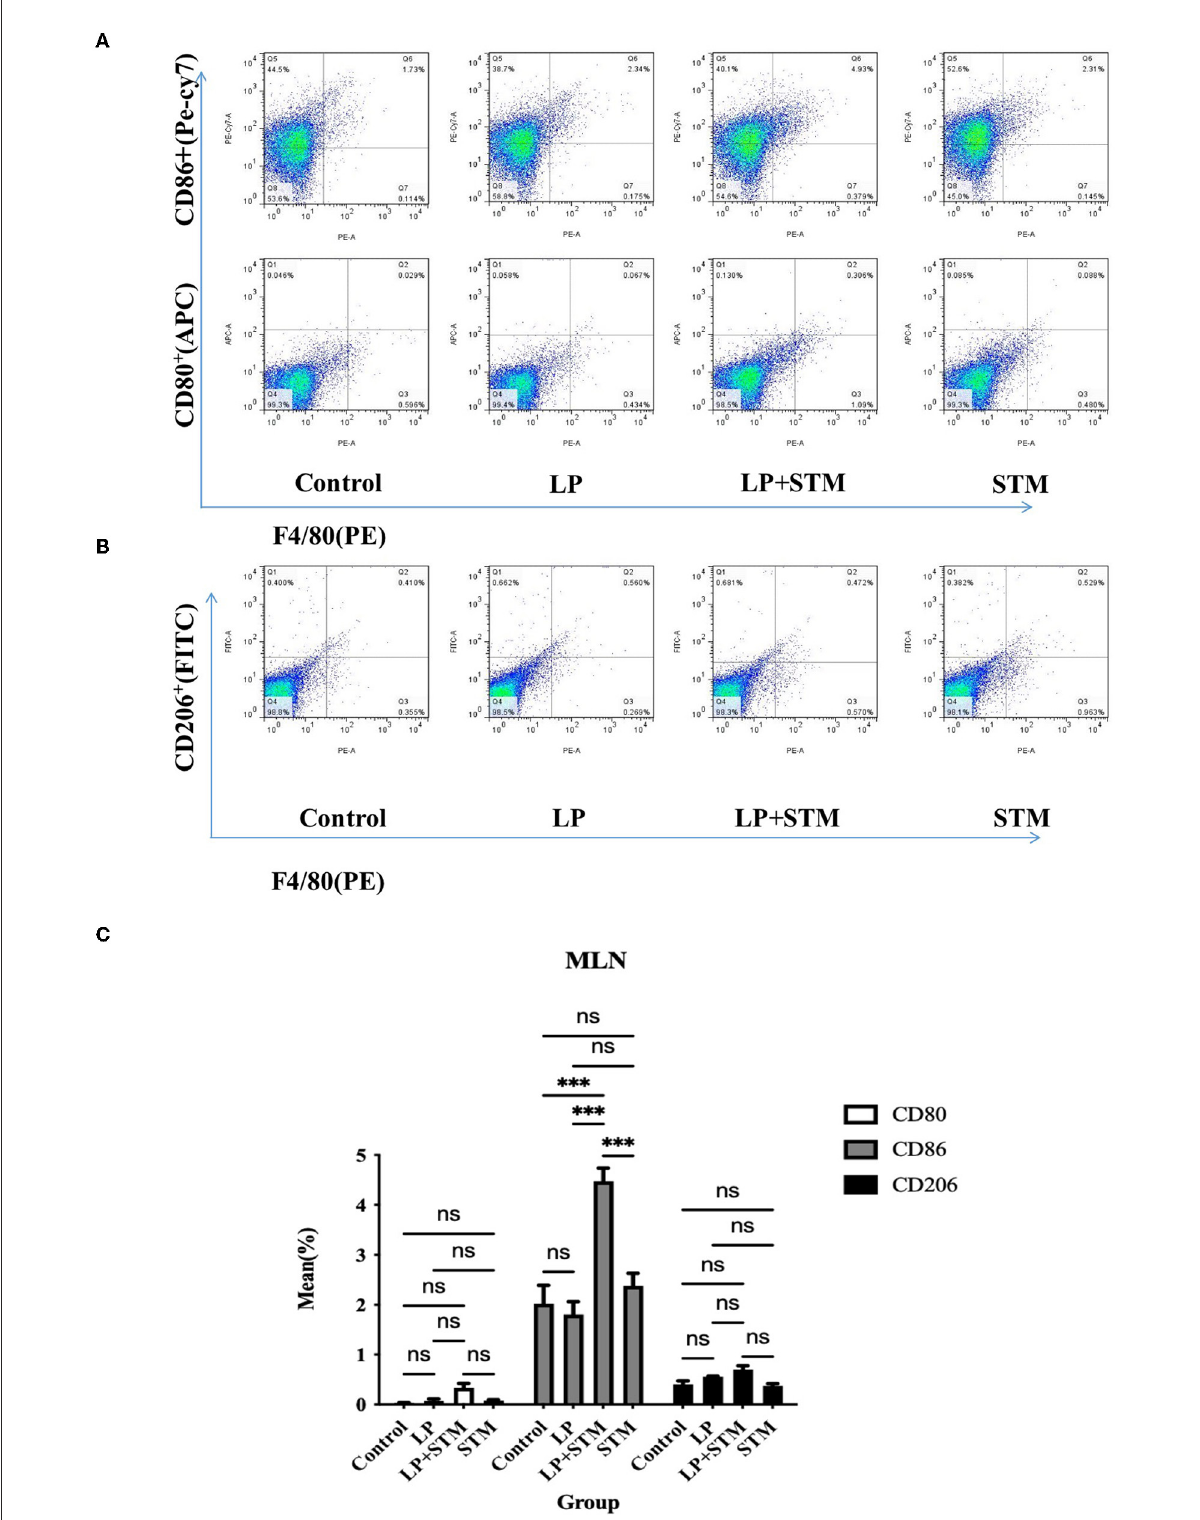
FIGURE6 LP pretreatment promoted M1 polarization in mouse MLN macrophages. (A,B) FCM analysis of the percentage of F4/80 + CD80 + or F4/80 + CD86 + or F4/80 + CD206 + cells in MLN from each group. (C) Statistics of proportion of F4/80 + CD80 + , F4/80 + CD86 + , F4/80 + CD206 + cells. Results are presented as means ± SD (data were analyzed using one-way ANOVA. ns not significant, * p < 0.05 , ** p < 0.01 , *** p <